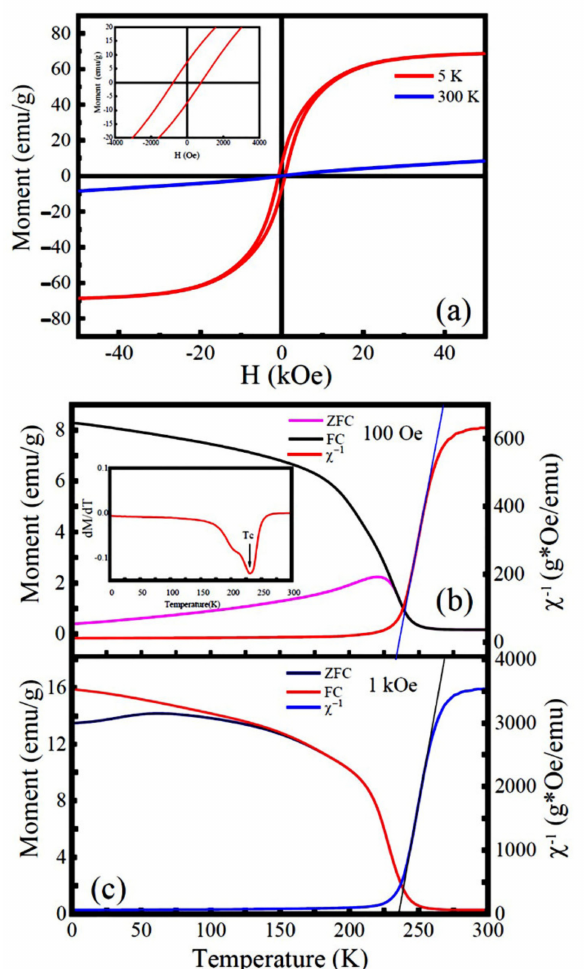
Figure 8. ( a ) M - H hysteresis loops of the LNMO NRs recorded at 5 K and 300 K. Inset is local enlarged M-H curve. ( b , c ) Temperature dependent dc magnetizations measured under ZFC and FC modes with applied magnetic fields of 100 Oe and 1000 Oe, respectively, and the temperature dependence of reciprocal ZFC magnetic susceptibilities, χ − 1 measured at 100 Oe and 1000 Oe (right Y column), respectively. Inset in ( b ) is d M ZFC /d T versus temperature to determine the magnetic Curie temperature ( T C